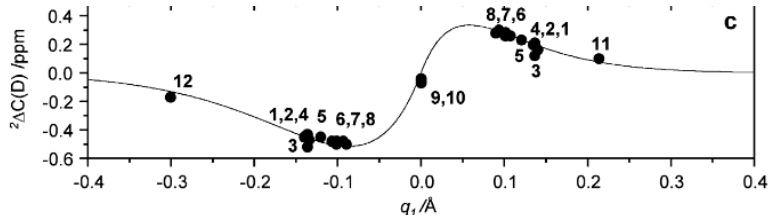
Figure 24. Plot of two-bond deuterium isotope effects on 13 C chemical shifts of a series of primarily homoconjugated anions of carboxylic acids vs. q 1 . Data points for 11 and 12 are heteroconjugated dimers. q 1 = 0.5(r OH − r HO ). Reprinted with permission from Ref. [60]. Copyright 2012 American Chemical Society.